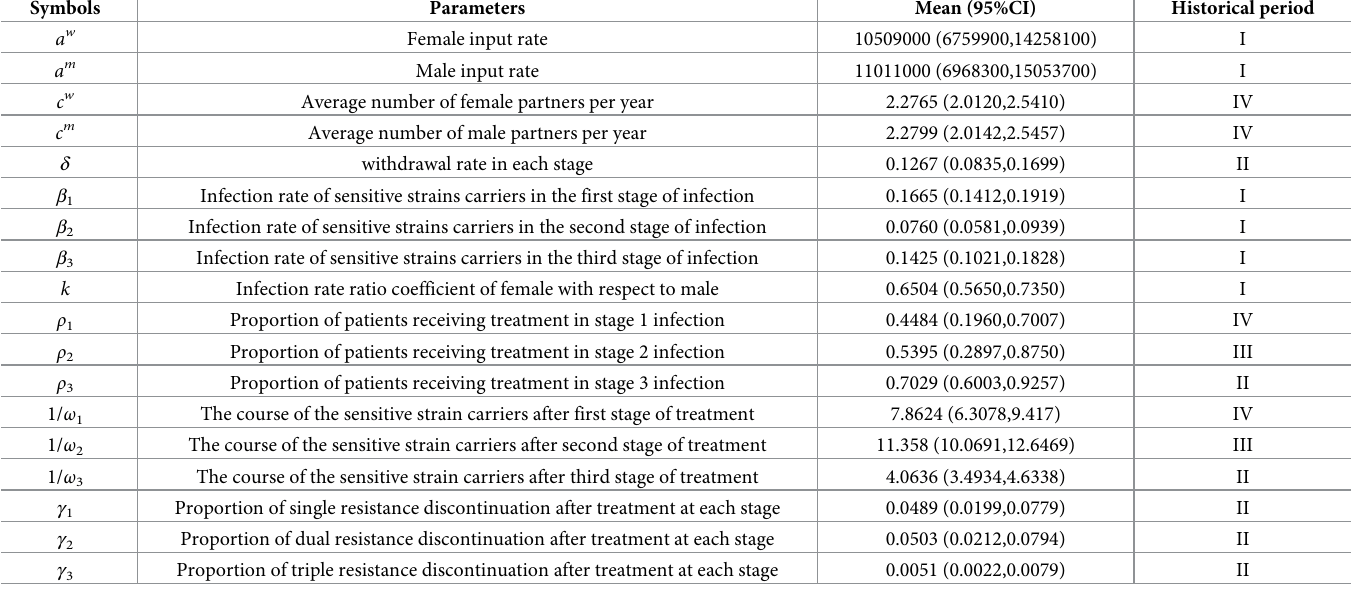
Table 4. Fitted parameters by MCMC for dynamics